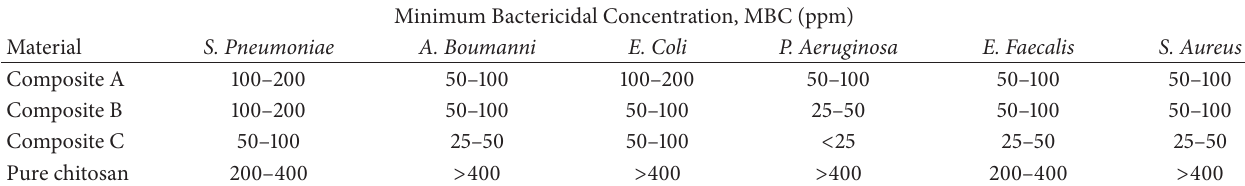
Table 1: Antibacterial effect of chitosan-Ag nanoparticle composite materials.